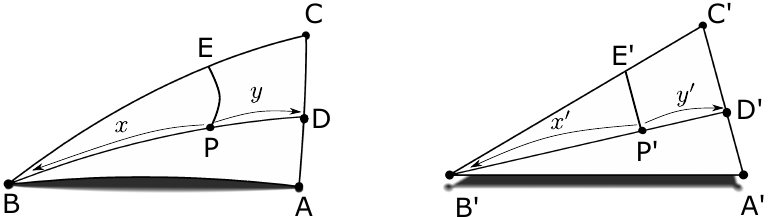
Figure 6. Notice that regions BDC and BPE are both portions of a spherical cap. The area of a spherical cap is proportionate to the angle that it subtends so the area of BDC is proportionate to 1 − cos ( x + y ) and the area of BPE is proportionate to 1 − cos ( x ) . Also notice that regions B (cid:48) D (cid:48) C (cid:48) and B (cid:48) P (cid:48) E (cid:48) are similar triangles. The area of similar planar triangles is proportionate to the square of their side length so the area of the triangle B (cid:48) D (cid:48) C (cid:48) is proportionate to ( x (cid:48) + y (cid:48) ) 2 and the area of B (cid:48) P (cid:48) E (cid:48) is proportionate to x (cid:48) 2